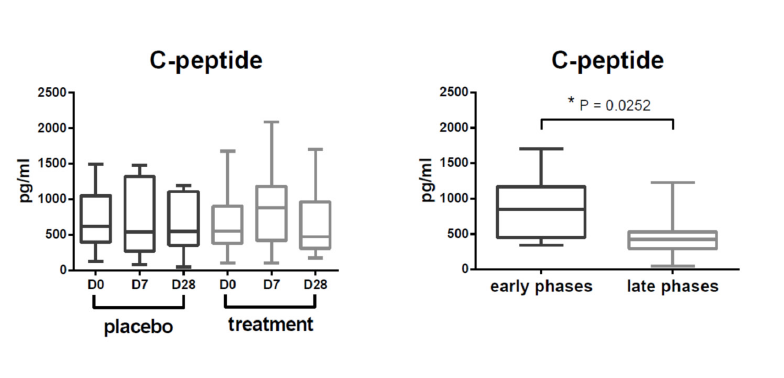
Fig. 4. Comparison of C-peptide levels during the early and late phases of tissue healing. We found statistically significant differ- ences for C-peptide